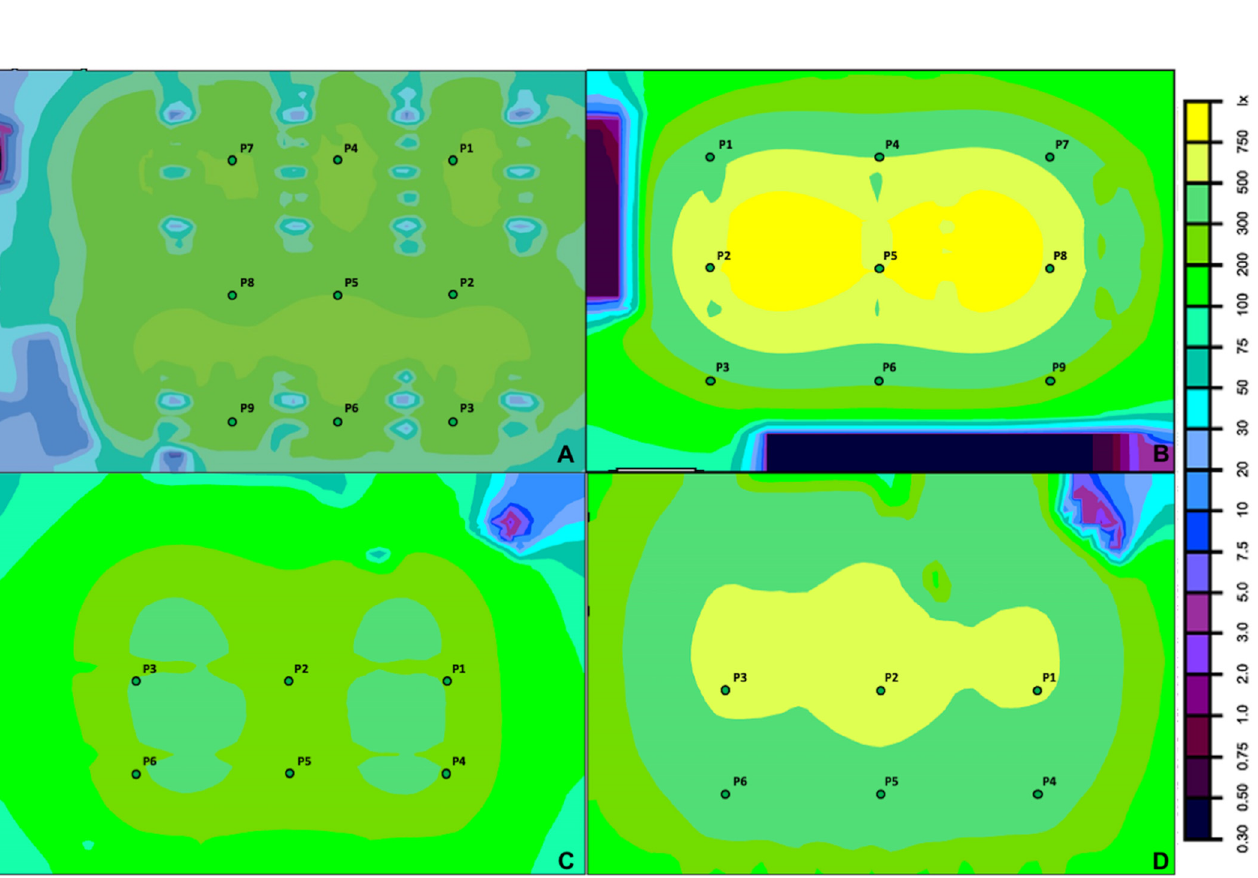
Figure 3. Photopic illuminance (lux) in false color at the horizontal plane (height 0.80 m from the floor). ( A ) Classroom 1; ( B ) Classroom 2; ( C ) Classroom 3; ( D ) Classroom 4 and measurement number points for each classroom.